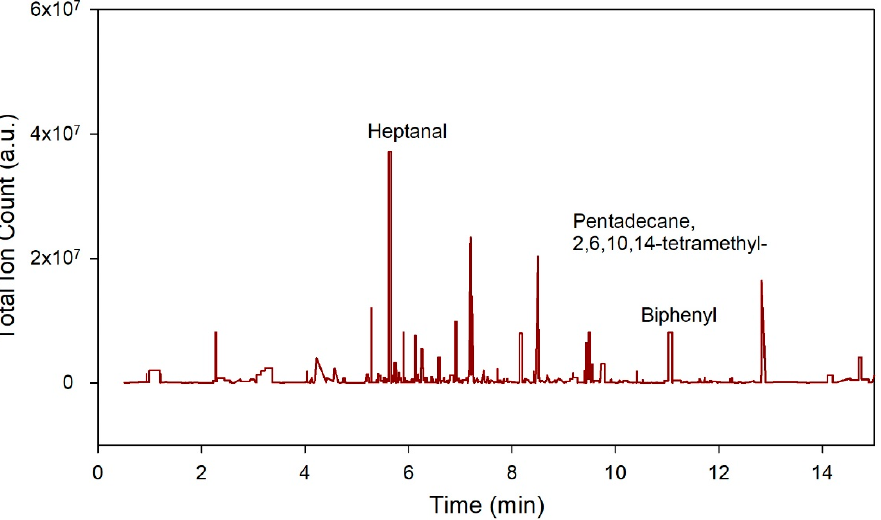
Figure 3. Figure illustrates a typical output plot of gas chromatography time-of-flight mass spectrometry (GC-TOF-MS). The x -axis in the plot represents the retention time and y -axis lists the chemical according to their abundance in the sample. Table 2. GC-IMS diagnostic group